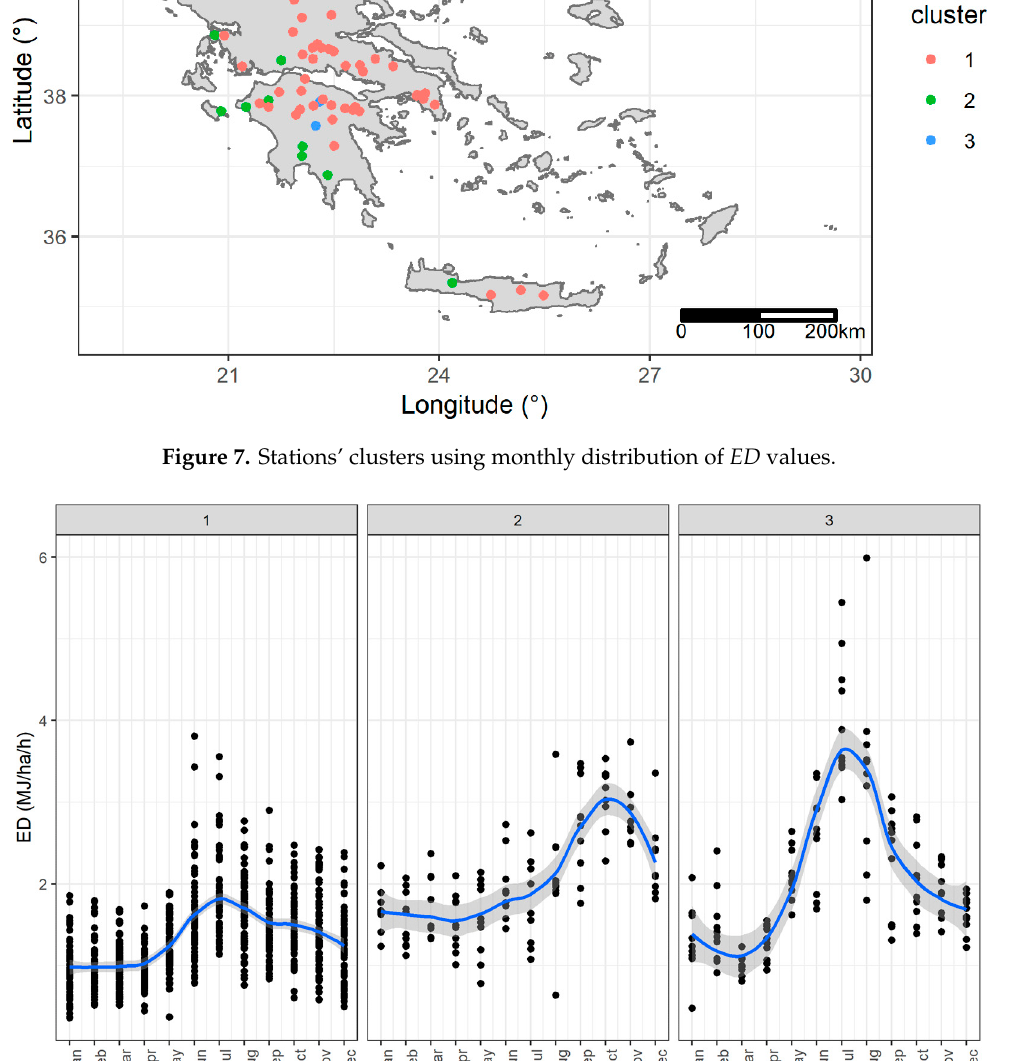
Figure 8. Monthly ED distribution values from the emerged clusters. Black dots symbolize the monthly values per station. The blue lines are the LOESS lines that are fitted to the data per cluster. The grey areas represent the standard error of LOESS.